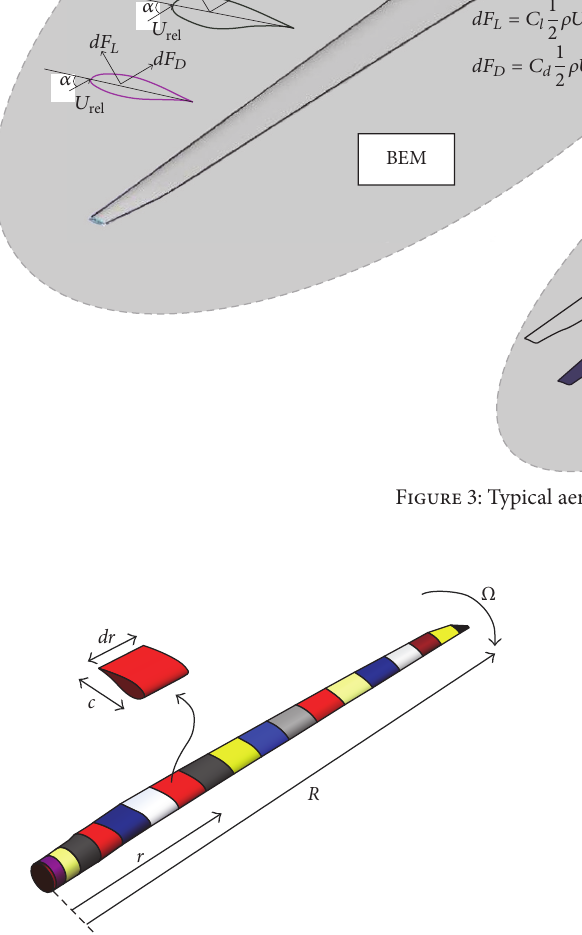
Figure 4: Schematic of finite number of elements of the blade (blade element theory).